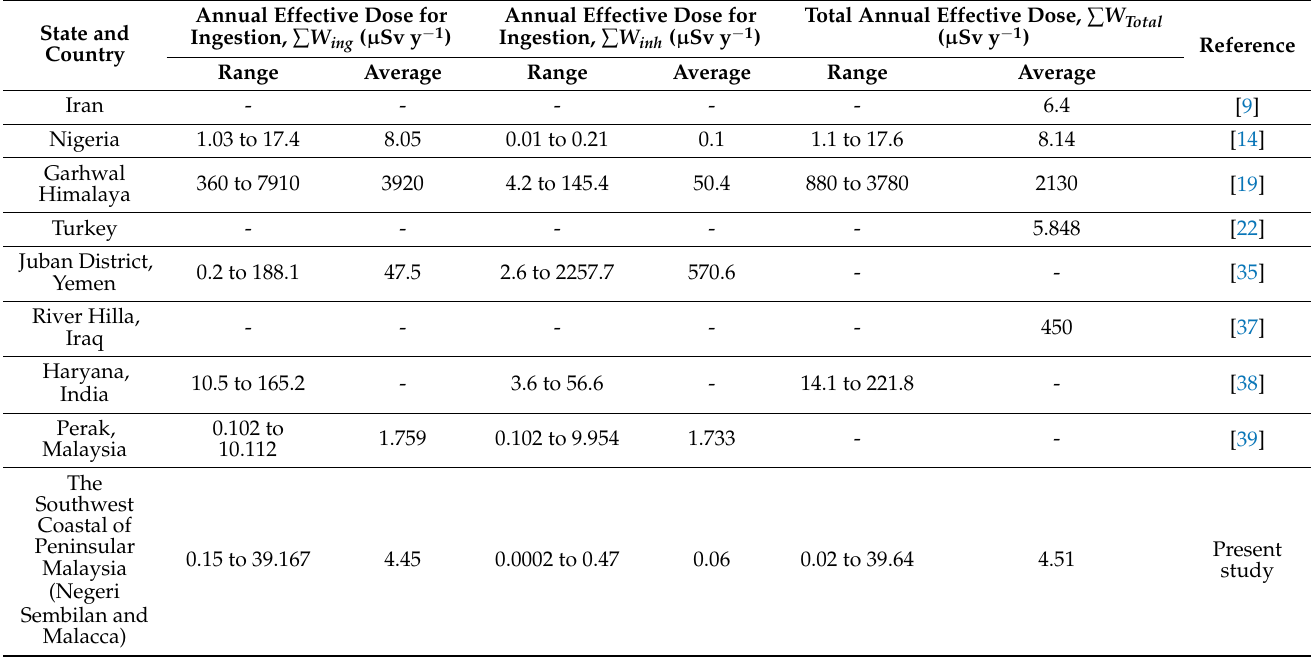
Table 4. The annual effective dose from the consumption of drinking water in other countries. State and